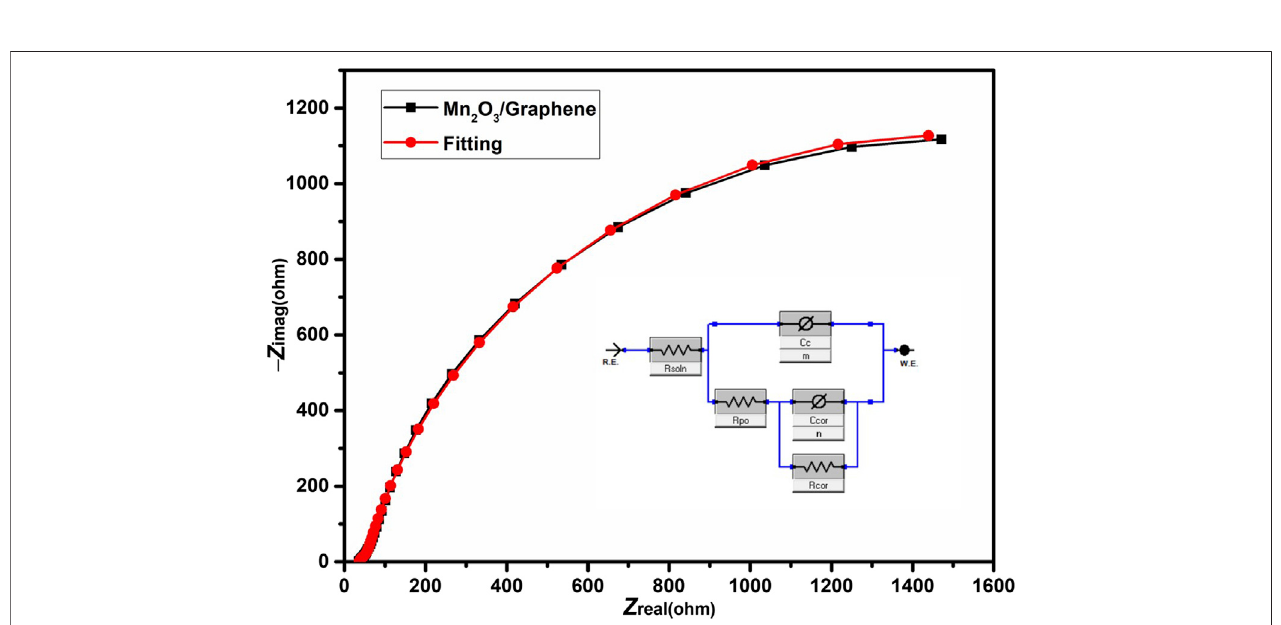
Frontiers in Chemistry |